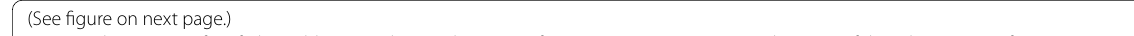
figure on next Fig. 5 Adoptive transfer of plasmablasts accelerates the onset of T1D in NOD/SCID mice. A Schematic of the adoptive transfer experiment. B Representative plots indicating the reconstruction of adoptively transferred cells in the spleen of recipient mice 4 weeks after transfer. C Representative images indicating the staining of plasmablasts (CD138 + , red) and CD4 + or CD8 + T cells (green) in the pancreatic islets from recipients. Insulin, pink. Dapi, blue. Scale bar: 50 μm; 20 μm (inset). D Blood glucose levels of recipient mice. E Diabetes incidence of recipient mice. Figure D&E show the pooled data of two independent experiments. Log-rank test. * P < 0.05. F Representative H&E staining of pancreas from recipient mice. Scale bar: 200 μm; 50 μm (inset). G A bar graph showing insulitis severity in indicated groups. Chi-square test. These data are representative of two independent